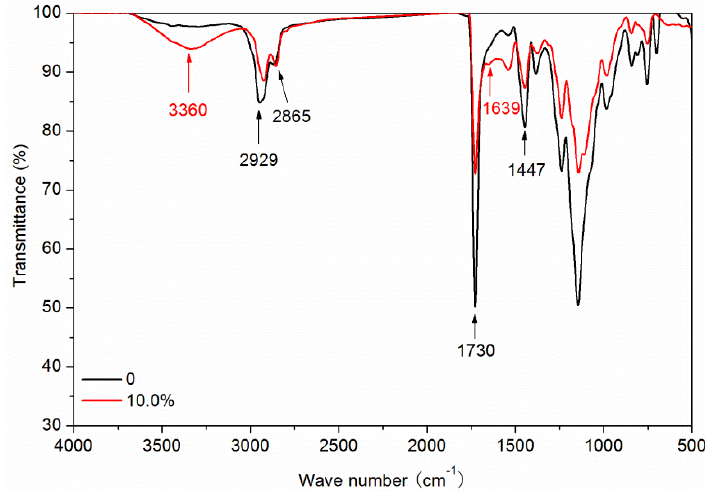
Figure 5. FTIR of the paint film with “3 layers of primer, 2 layers of topcoat”: 0 and 10.0% microcapsule in primer.